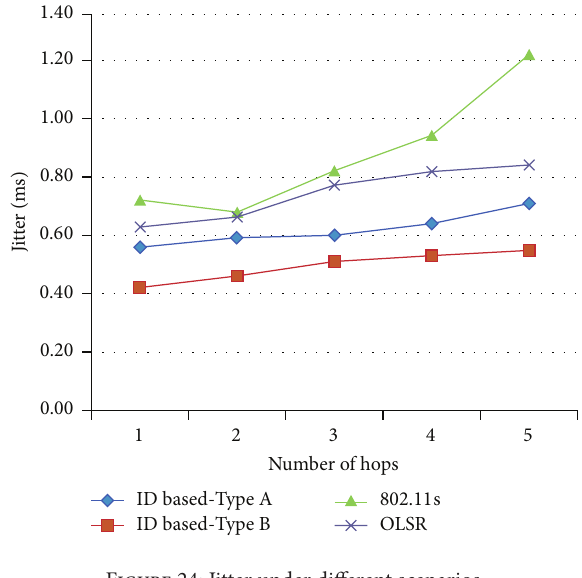
Figure 24: Jitter under different scenarios.